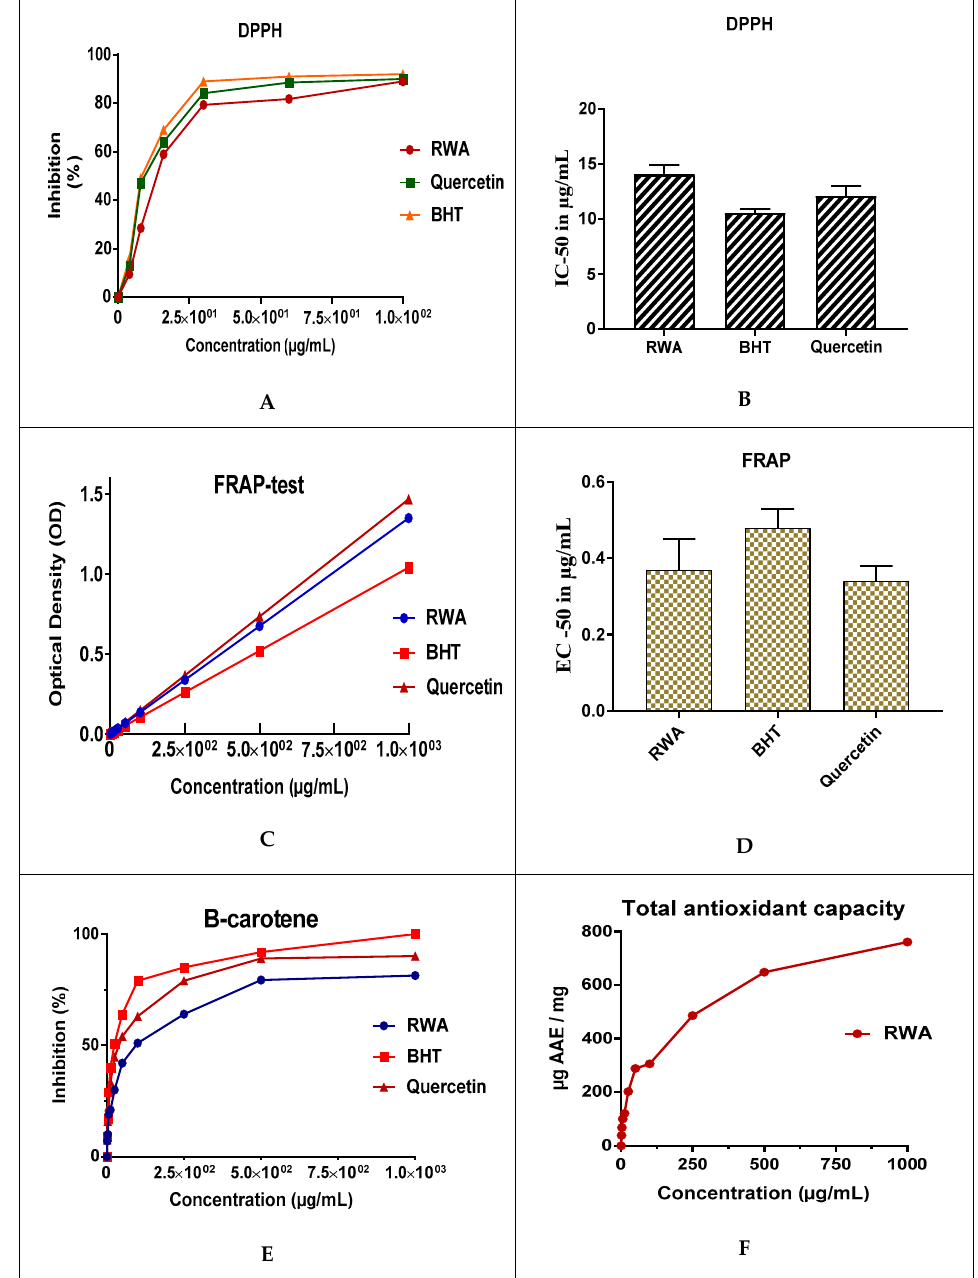
Figure 2. Antioxidant activity of RWA by DPPH (A and B), FRAP (C and D), TAC (E), and β - carotene (F).